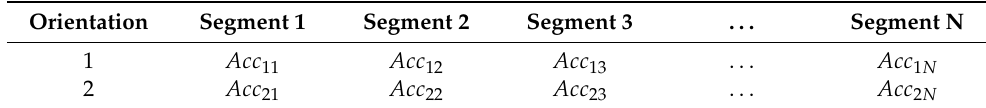
Table 1. Matrix that contains the tests average accelerations.